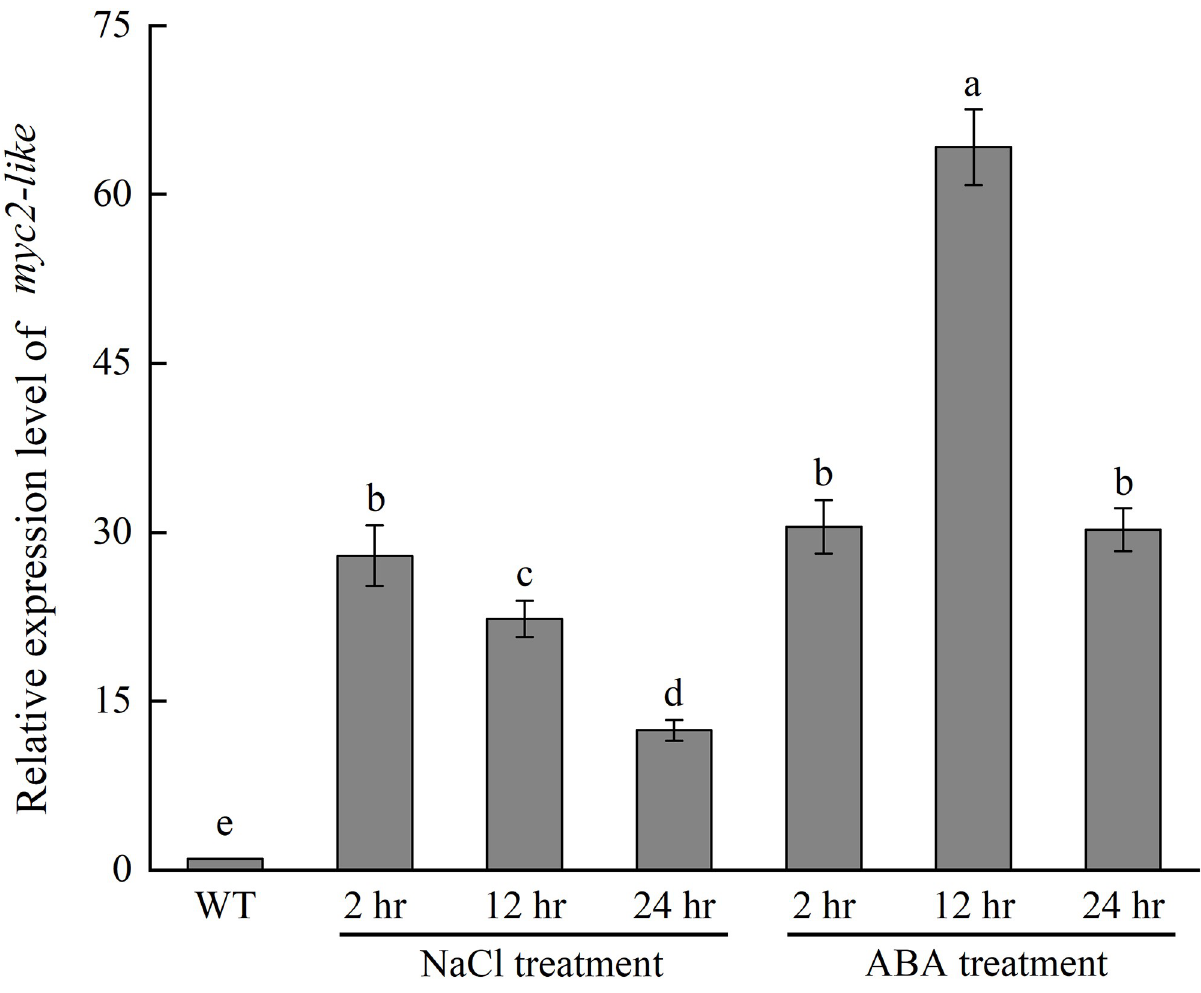
Fig 4. Relative transcript level of the MYC2-like induced by salt and ABA. Error bars represent the standard deviation.